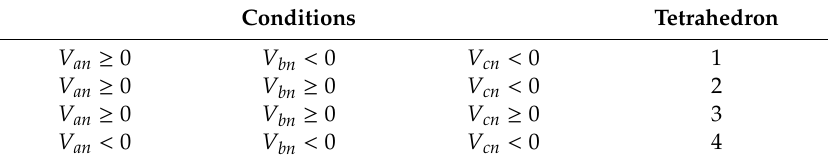
Table 3. Look up table for choosing correct switching sequence.